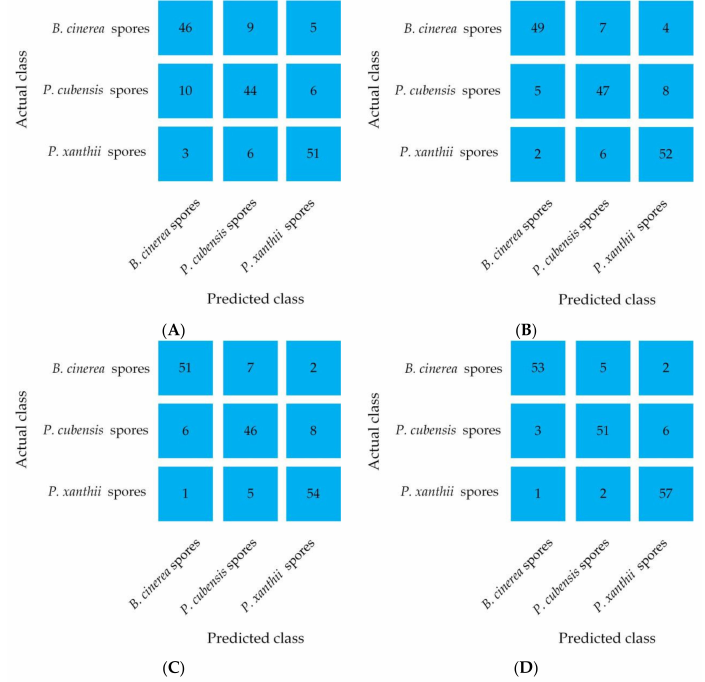
Figure 8. Confusion matrix of different classification models, ( A ) LR model, ( B ) KNN model, ( C ) RF model, and ( D ) SVM